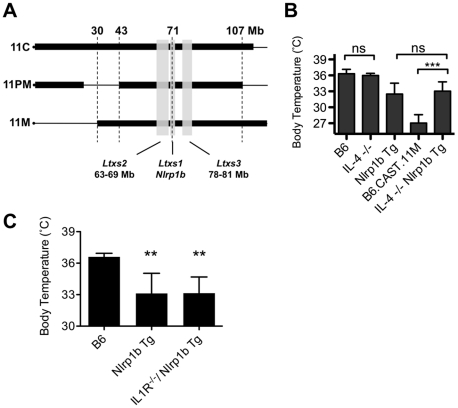
The role of IL-4 in the Nlrp1b-mediated response to LT.
A, Comparative maps of mouse chromosome 11 B6.CAST strains. Thin horizontal lines indicate homozygous B6 sequence, while thick boxes indicate homozygous CAST/Ei sequence. Physical locations are shown on top. Vertical gray boxes denote QTL Ltxs1-3. Locations are as follows (physical / recombination boundaries): Ltxs2 = 63–69 Mb / 34.5 - 37 cM; Ltxs1 = 69.5–71 Mb / 40–43 cM; Ltxs3 = 78–81 Mb / 44–46 cM. B, Mice deficient for the IL4 gene and expressing a LT-sensitive allele of Nlrp1b (B6Nlrp1b
(129S1)/IL4
−/−) (n = 7), mice deficient for the IL4 gene and expressing a LT-resistant allele of Nlrp1b (IL4
−/−) (n = 7) were injected i.p. with 15 µg PA+7.5 µg LF per g body weight, and body temperatures were monitored hourly. The lowest temperature observed during the first 6 h post toxin injection is plotted as mean values +/− SD. Data for controls (B6, B6Nrlp1b
(129S1) and B6.CAST.11M) are re-graphed from Figure 1B for comparison to IL-4−/−. Lack of IL4 did not significantly alter response to LT compared to matched control groups. C, B6 (n = 5), B6Nlrp1b
(129S1) (n = 5), and B6Nlrp1b
(129S1)
IL-R
−/− (n = 10) mice were challenged i.p. with 15 µg PA+7.5 µg LF per g body weight and the lowest temperature observed during the first 6 h post toxin injection is plotted +/− SD. Lack of IL1R did not significantly alter response to LT in mice transgenic for Nlrp1b. **p<0.01 compared to B6 control.